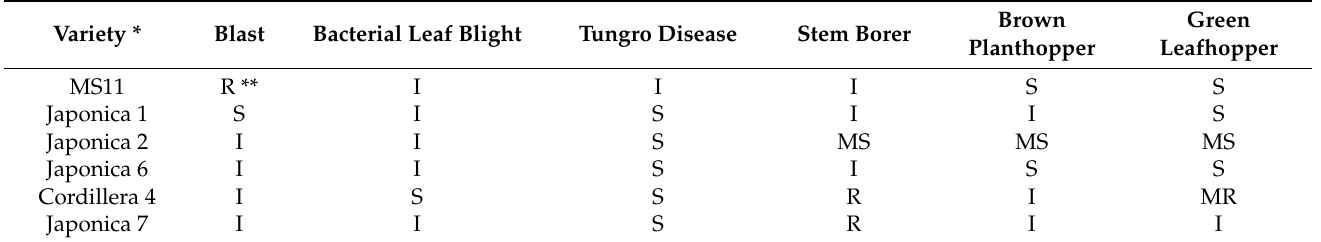
According to Kim et al. [4], the rice germplasm accessions originating from the tropi- cal/subtropical regions harbor the non-functional alleles of Hd1 associated with